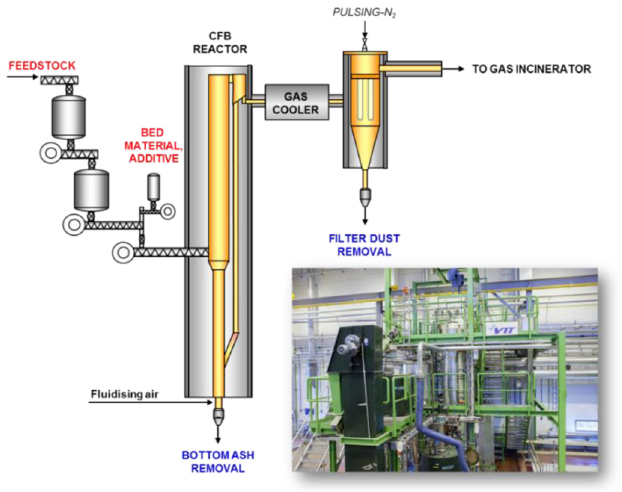
Fig. 5. Pilot-scale Circulating Fluidised-Bed (CFB) gasi fi cation test